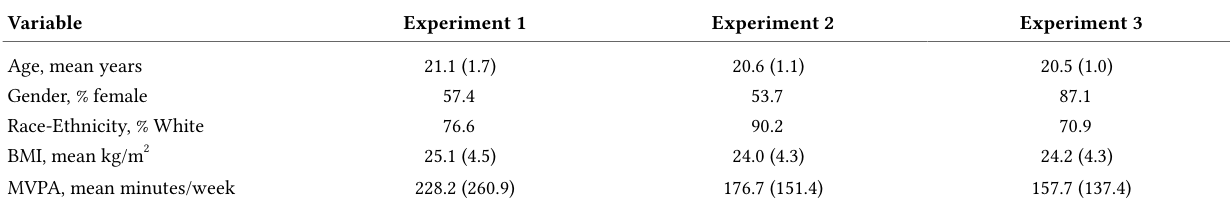
Participant Characteristics Across the Three Experiments